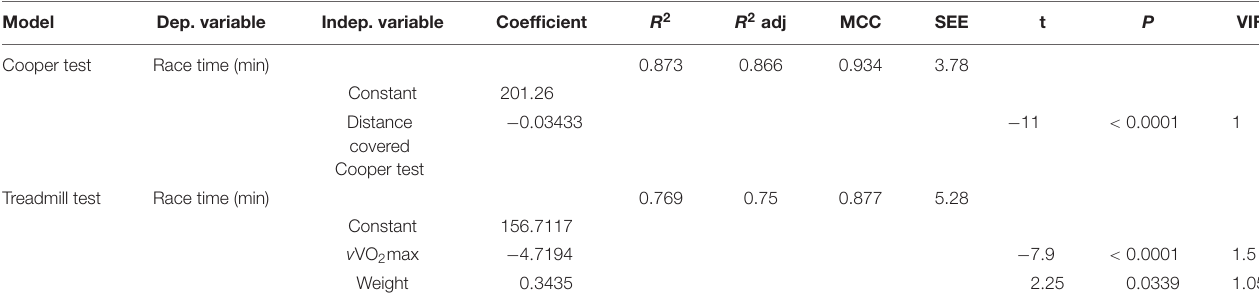
TABLE 5 | Multiple regression models derived from field and laboratory tests.